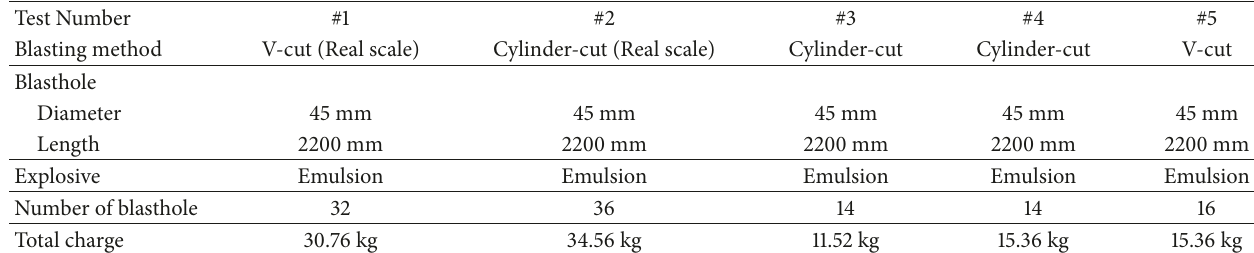
Figure 3: Shape of Blastmate series. Table 1: Conditions of each test